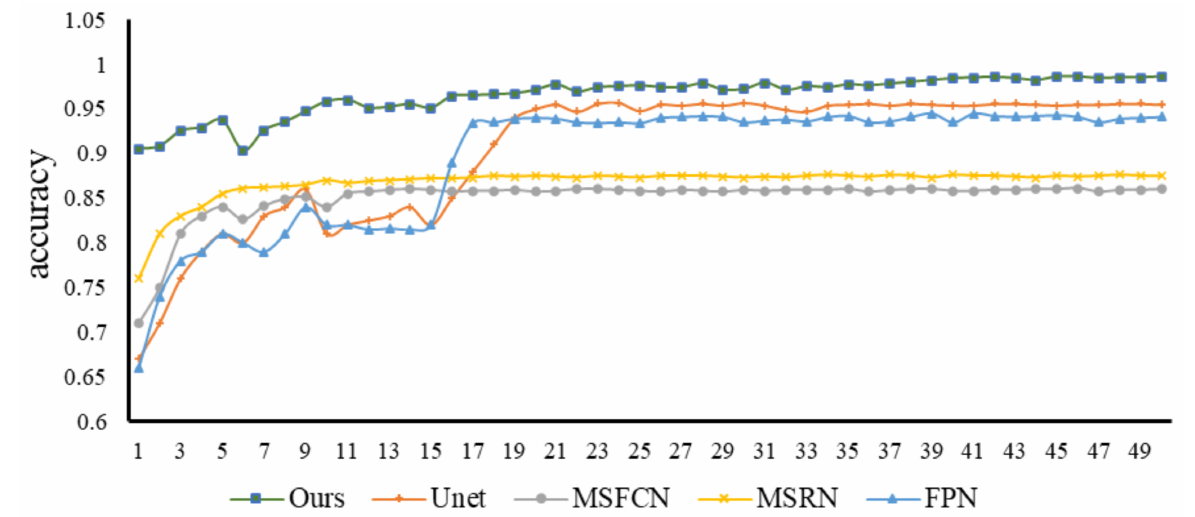
Figure 12. Accuracy changes of each model.